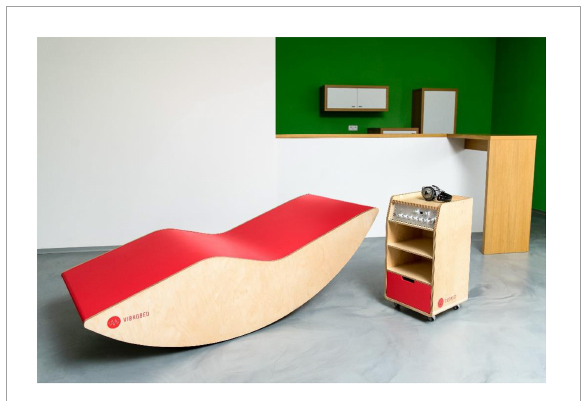
FIGURE1 Rehabilitation vibrating bed VIBROBED R (cid:13) , participants were supine on it (from the authors’ archive,